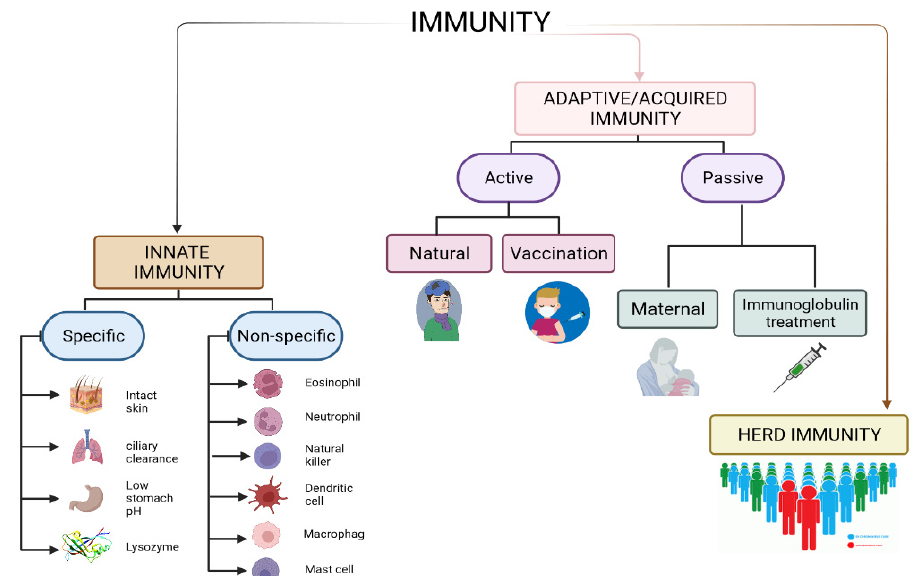
Figure 2. The types of immunity. Immunity refers to the ability of the body to prevent the invasion of foreign disease-causing microorganisms or substances. It is divided into innate and acquired immunity. The figure was prepared using Biorender (https://app.biorender.com; accessed on 14 March 2022).